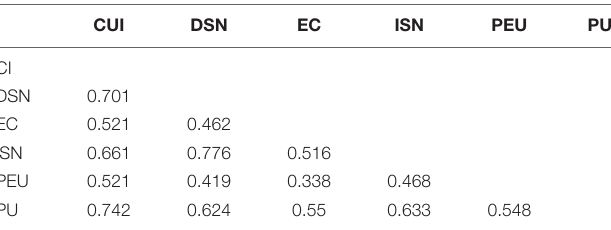
TABLE 5 | Heterotrait-monotrait (HTMT) ratio.